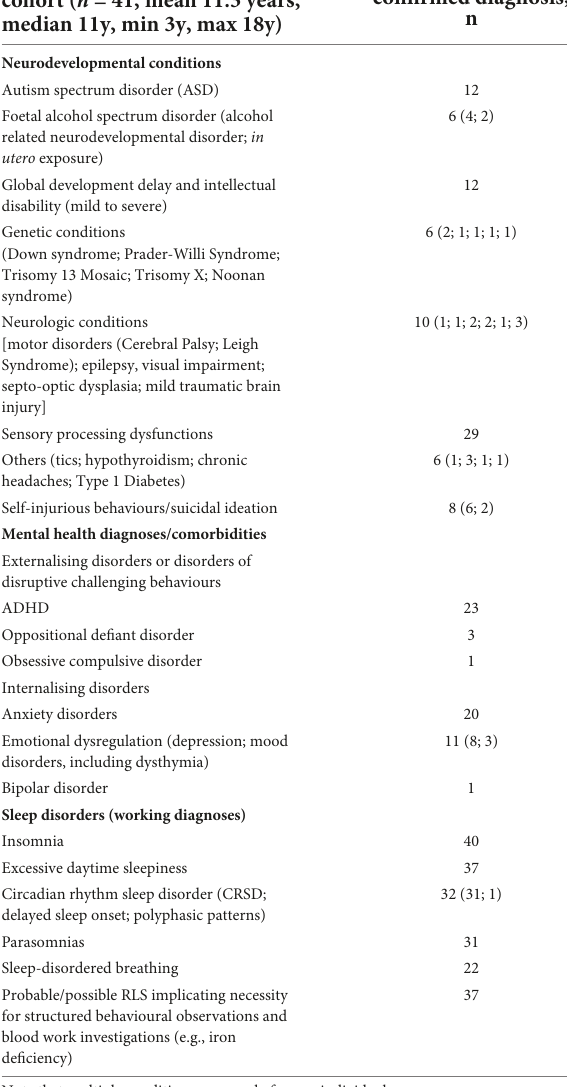
TABLE 1 Patient characteristics of 41 consecutive patients between the ages of 3 and 18, who were seen between